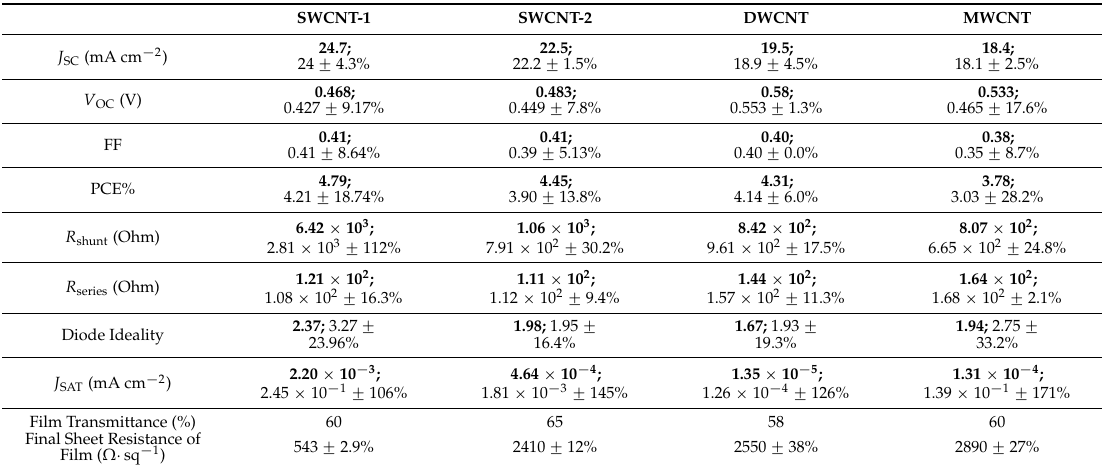
Table 4. Solar cell properties for best performing cells for each CNT sample in bold text, average properties and error values for sets of three (two for the Carbon Allotropes DWCNT) cells in regular text. J SC : Short circuit current density. V OC : Open circuit voltage. PCE: Power conversion efficiency.